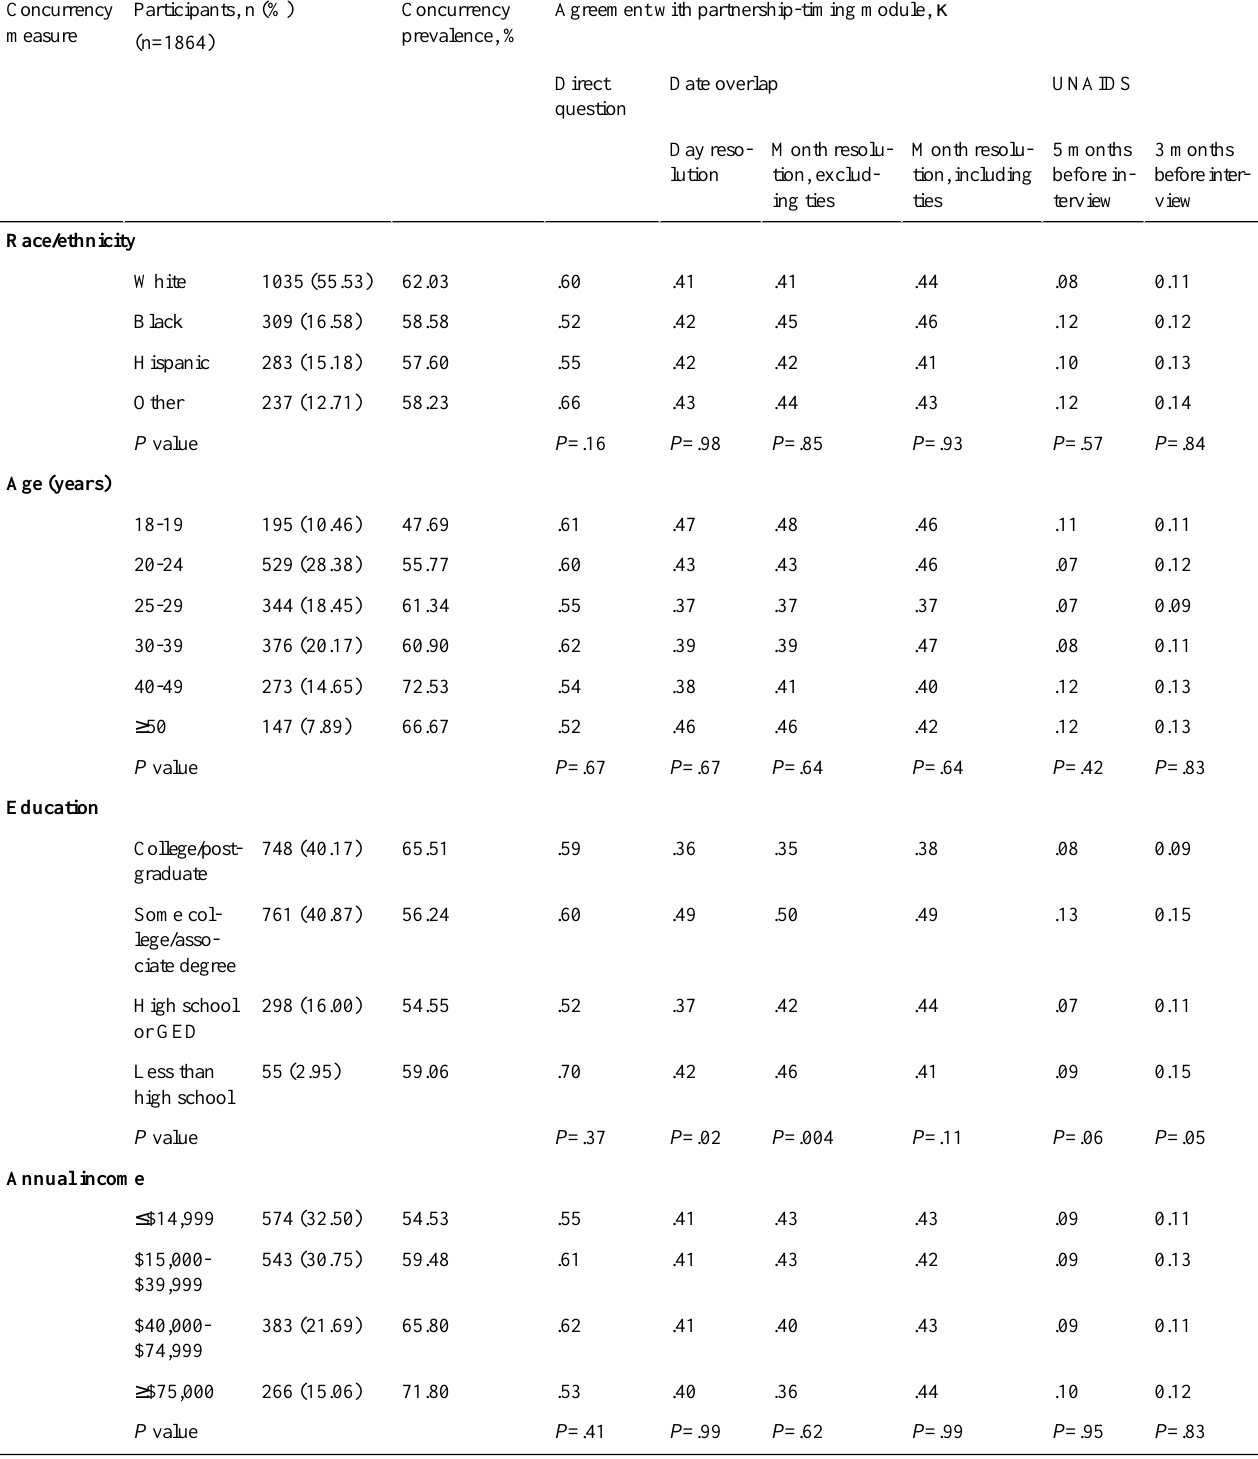
Table 4. Individual-level concurrency and correlates of agreement between the partnership-timing module and alternative measures of concurrency among men who have sex with men reporting multiple